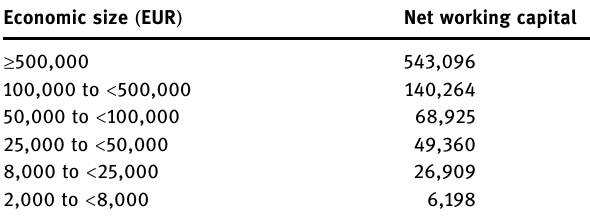
Table 4: Net working capital ( euros ) for the six economic sizes, on average over the period 2016 – 2018 and considering the former 28